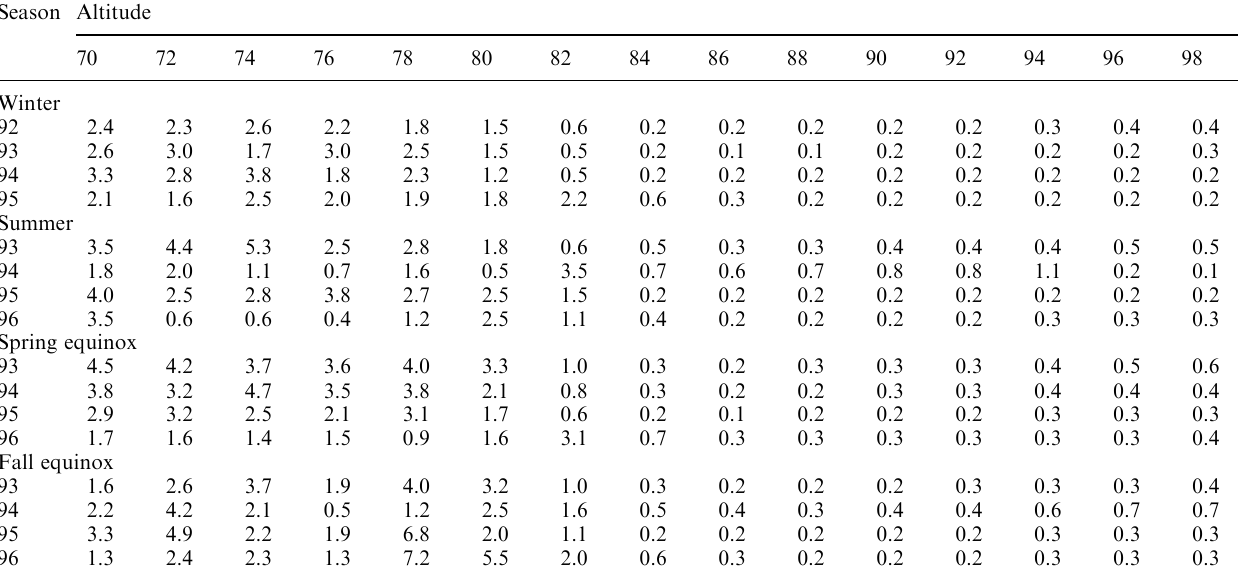
Table 1. Overall standard error for zonal wind Season Altitude